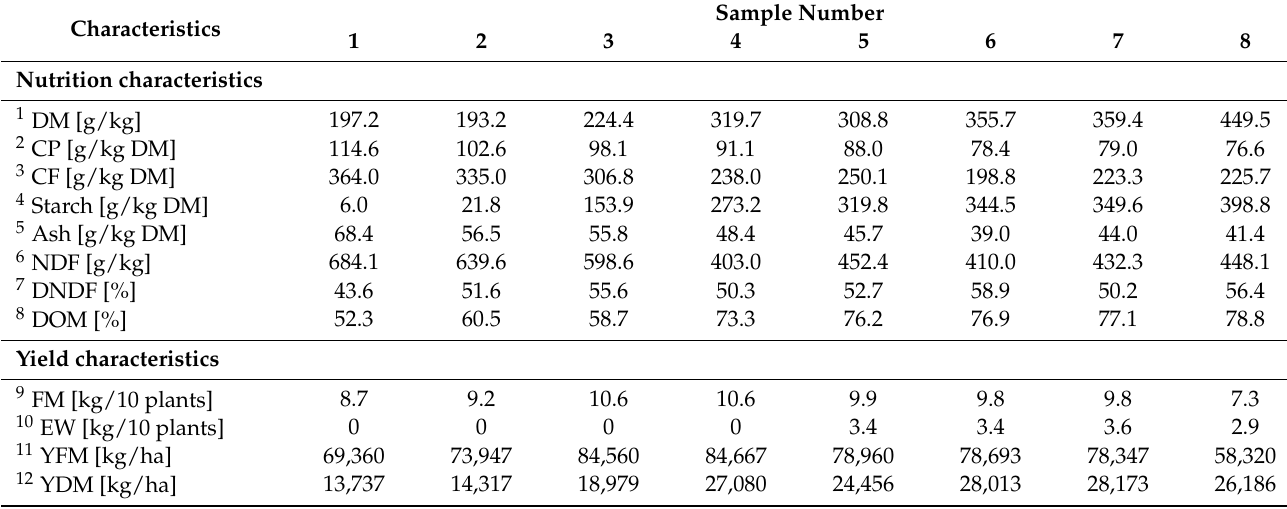
Table 2. The laboratory results obtained from plants collected at the different sampling stages.